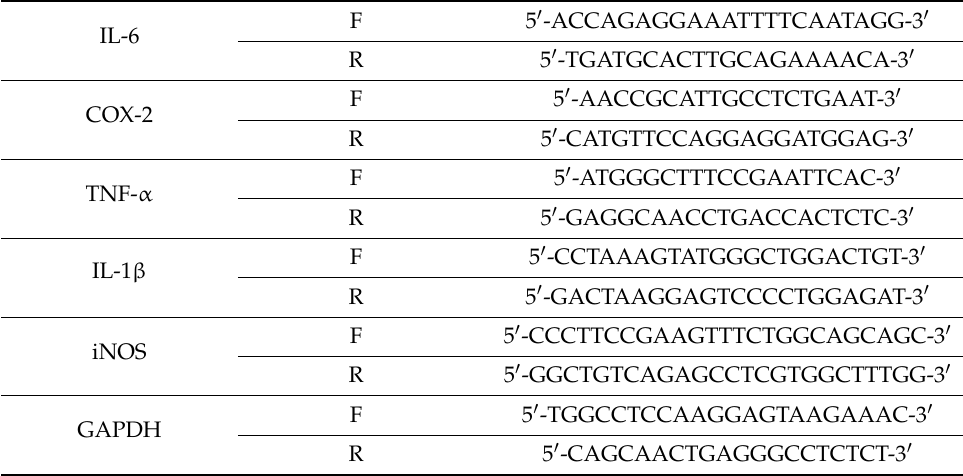
Table 1. The primer sequences used for quantitative real-time